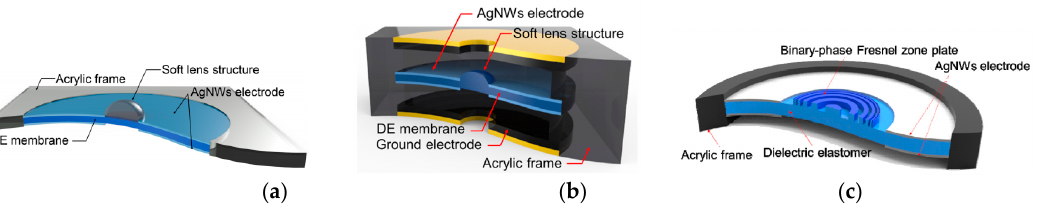
Figure 14. Structure illustration of all-polymeric lenses using DEAs: ( a ) a thin film active-lens [137]; ( b ) active-lens using hybrid driving force [138]; ( c ) a binary phase Fresnel lens